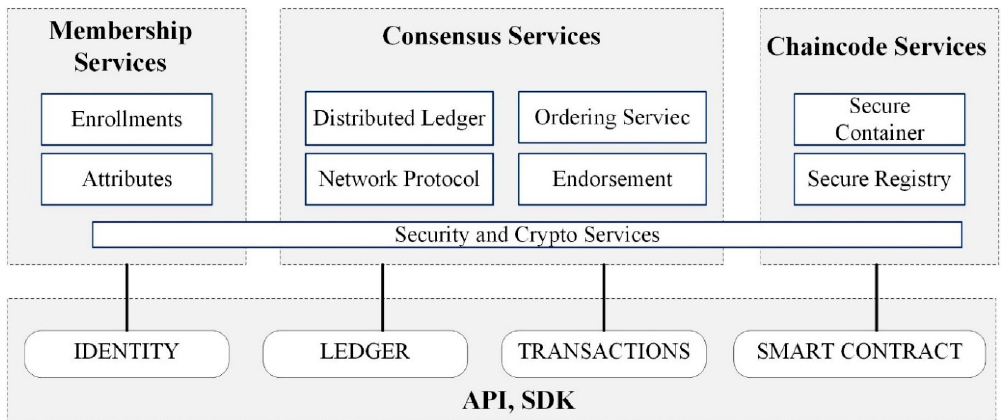
Figure 6. Application Programming Interface (API) , Hyperledger Fabric (HLF) System. SDK, Software Development Kit.